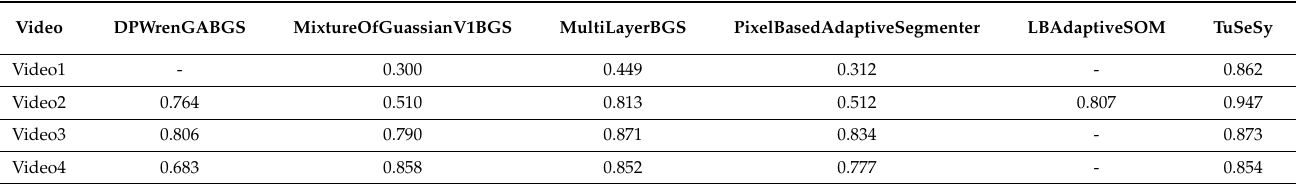
Table 1. F2-score of all measures (‘-’ represents failure in obtaining the